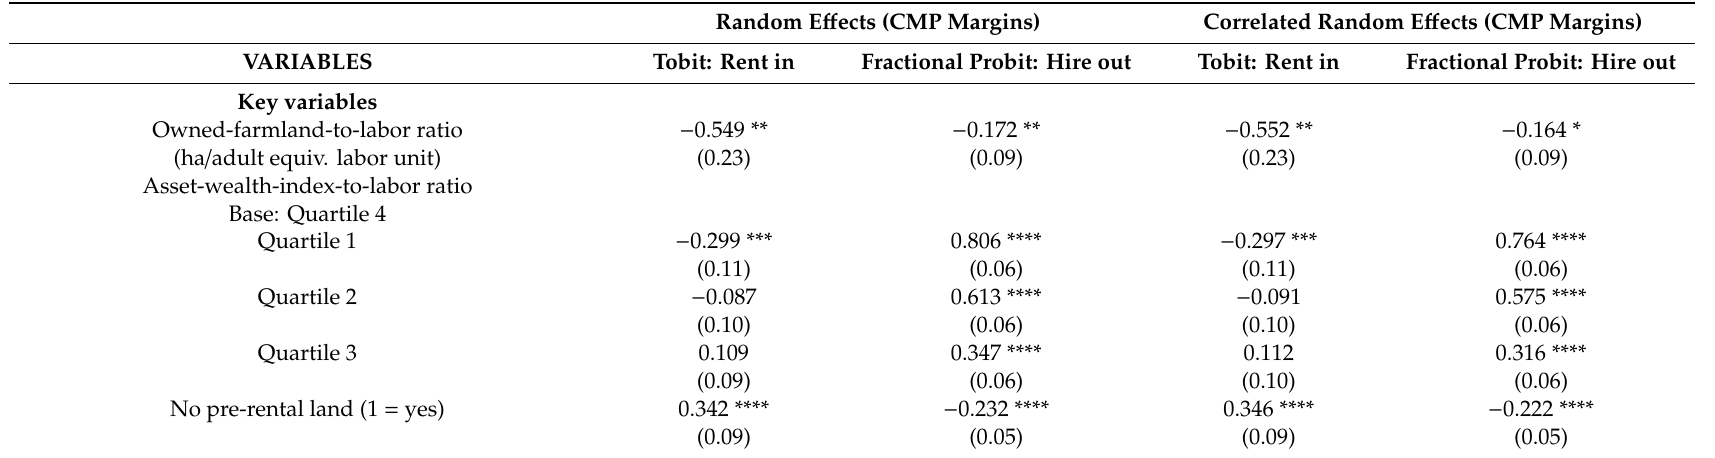
Table A5. Conditional mixed process (CMP) coe ffi cients from a systems approach using Tobit for the land rental markets and fractional probit for the share of adult equivalent labor hired out for casual work ( ganyu